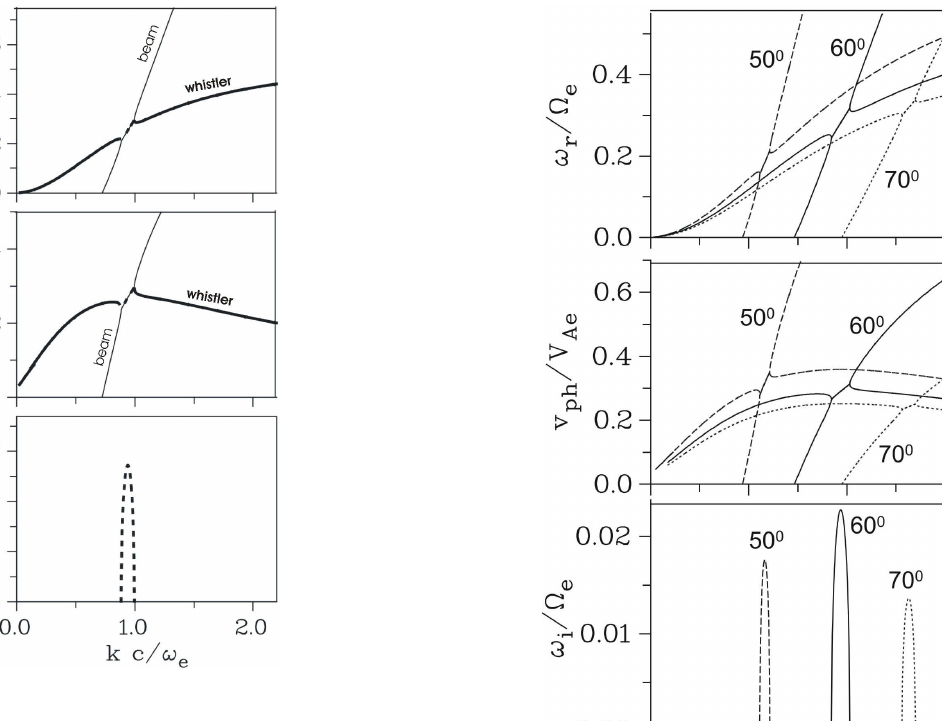
Fig. 1. Fluid dispersion of beam-excited whistlers at oblique prop- agation ( θ = 60 ◦ ); the beam density is n b = 0 . 01 n po , the beam velocity is V b = 2 . 5 V Ae . From top to bottom: real part of ω nor- malized to (cid:127) e , phase velocity normalized to V Ae and imaginary part of ω in normalized units versus the normalized wave number kc/ω e ( ω e is the electron plasma frequency). The thick solid lines in the upper two panels represent the whistler mode, the thin lines mark the Doppler-shifted cyclotron mode ω = − (cid:127) e + kV b cos (θ) . The instability occurs where both modes intersect.